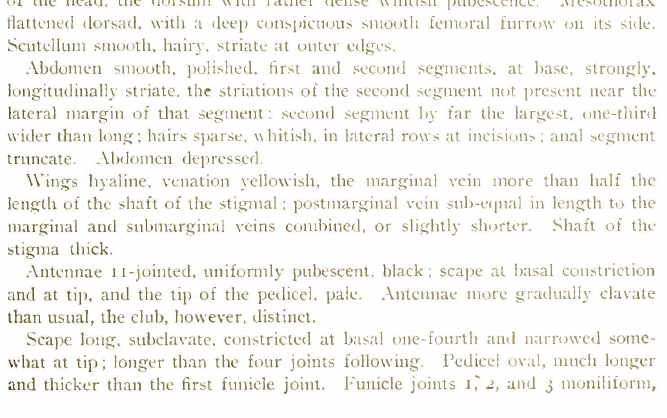
marginal and submarginal veins cumhined. or slightly shorter. ~haft of the stigma